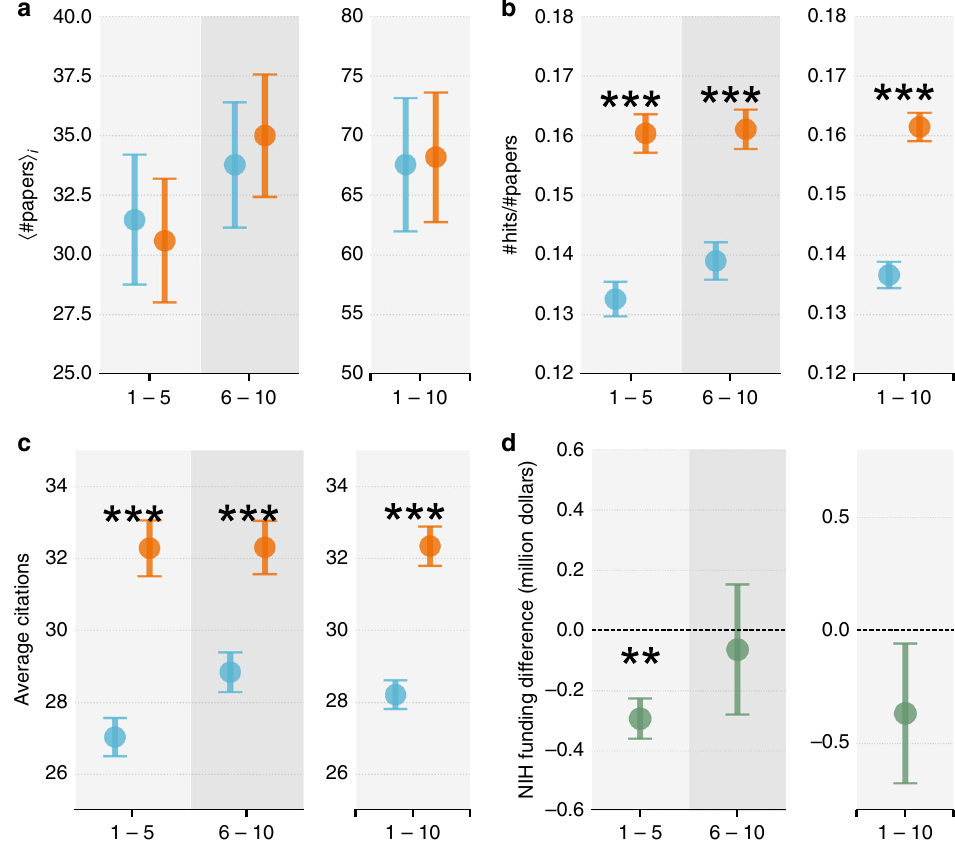
Fig. 2 Comparing future career outcome between near misses (orange) and narrow wins (blue). a The average number of publications per person. b Near misses outperformed narrow wins in terms of the probability of producing hit papers in the next 1 – 5 years, 6 – 10 years, and 1 – 10 years. Note that there appears a slight performance improvement for the narrow-win group in the second fi ve-year period, but the difference is not statistically signi fi cant ( χ 2 -test p -value > 0.1, odds ratio = 1.05). c Average citations within 5 years of publication. The near-miss applicants again outperformed their narrow-win counterparts. To ensure all papers have at least 5 years to collect citations, here we used data from 1990 to 2000 to avoid any boundary effect. d Funding difference between the near-miss and narrow-win group from the NIH (near misses minus narrow wins). *** p < 0.001, ** p < 0.05, * p < 0.1; Error bars represent the standard error of the